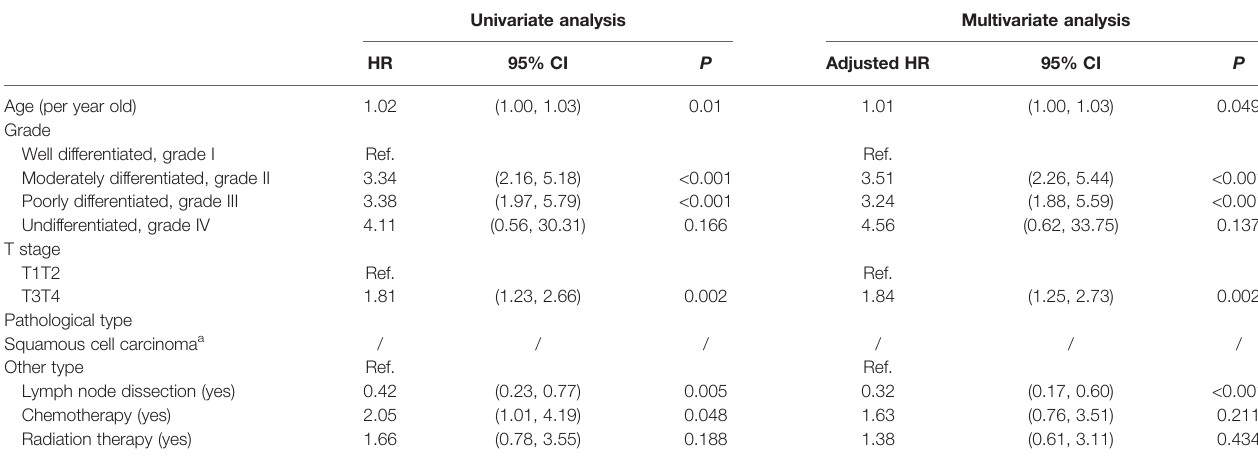
TABLE 3 | Univariate and multivariate Cox regression for cancer-speci fi c survival. Univariate analysis Multivariate analysis